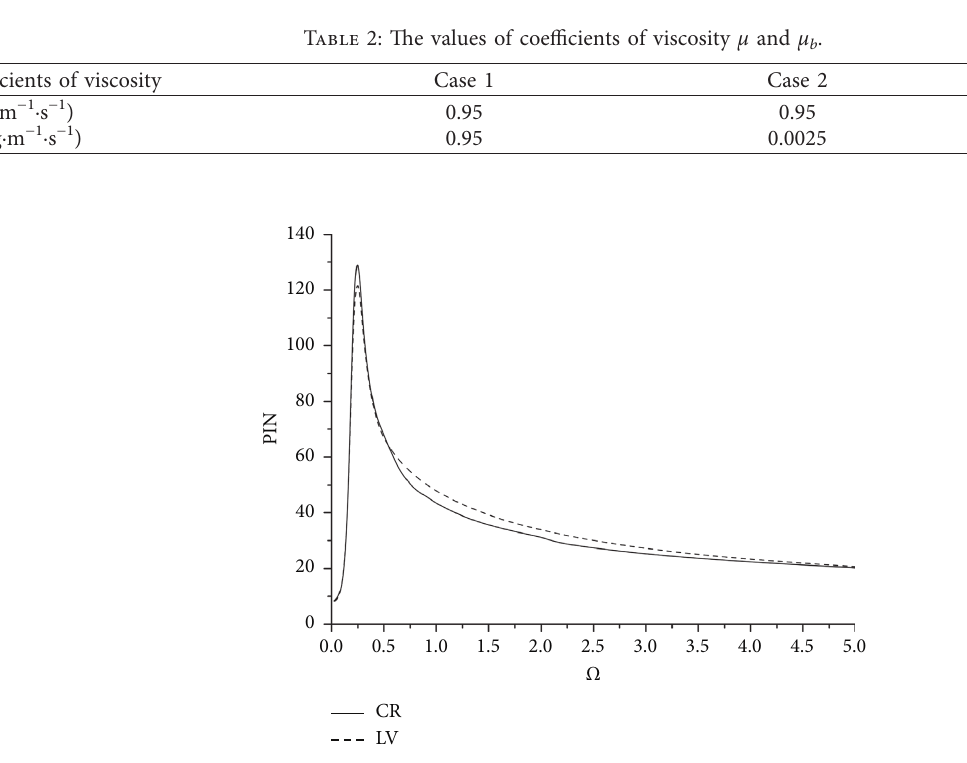
Figure 2: Comparison between the calculation results and the literature values ( n �